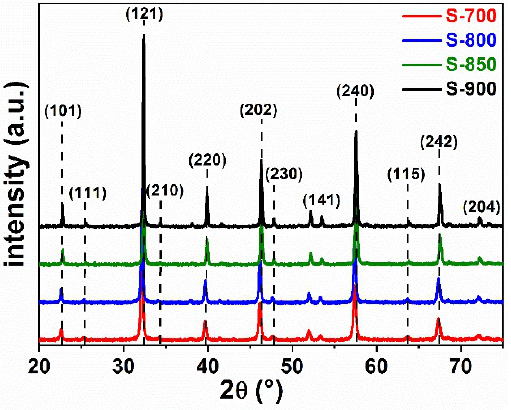
Figure 1. X-ray diffraction patterns of LaFeO 3 obtained at different calcination temperatures.